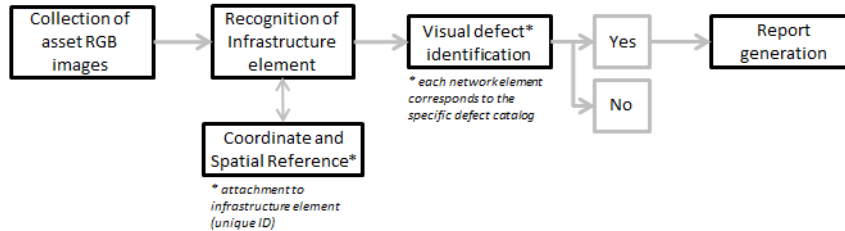
Figure 20. Visual defect identification workflow.